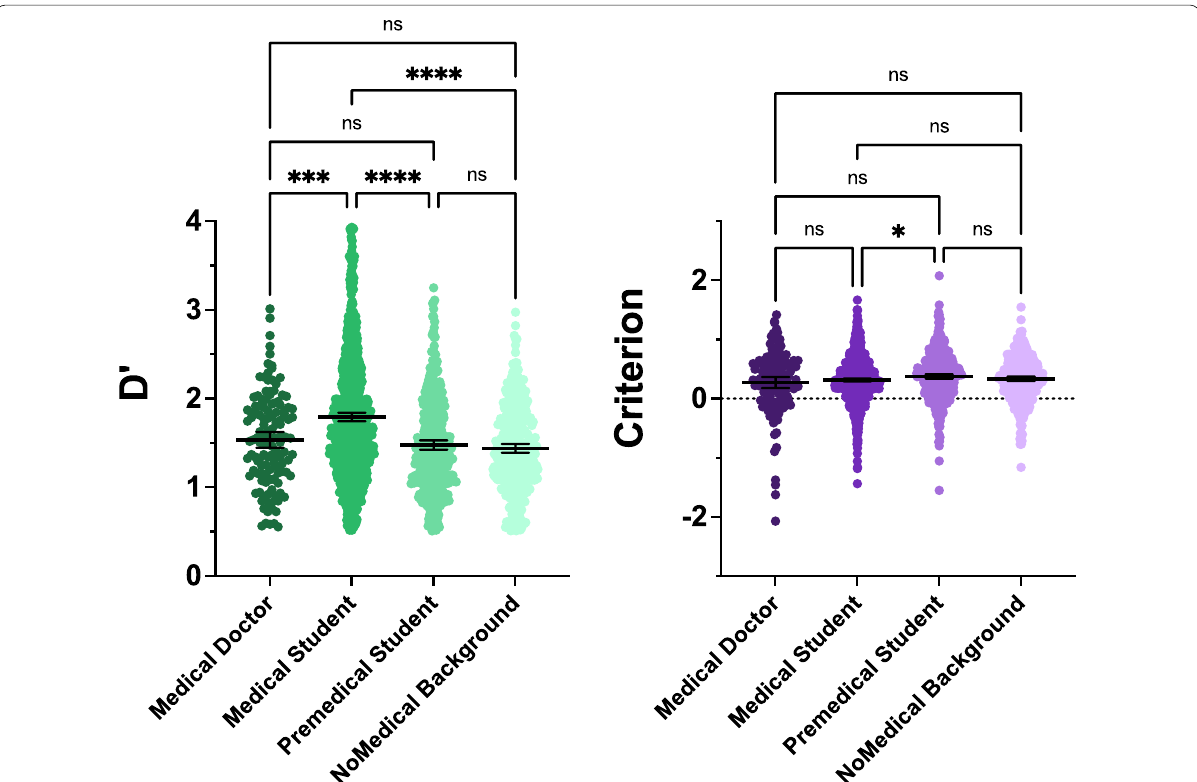
Fig. 9 Effects of expertise category on d ′ and crit, regardless of prevalence and/or